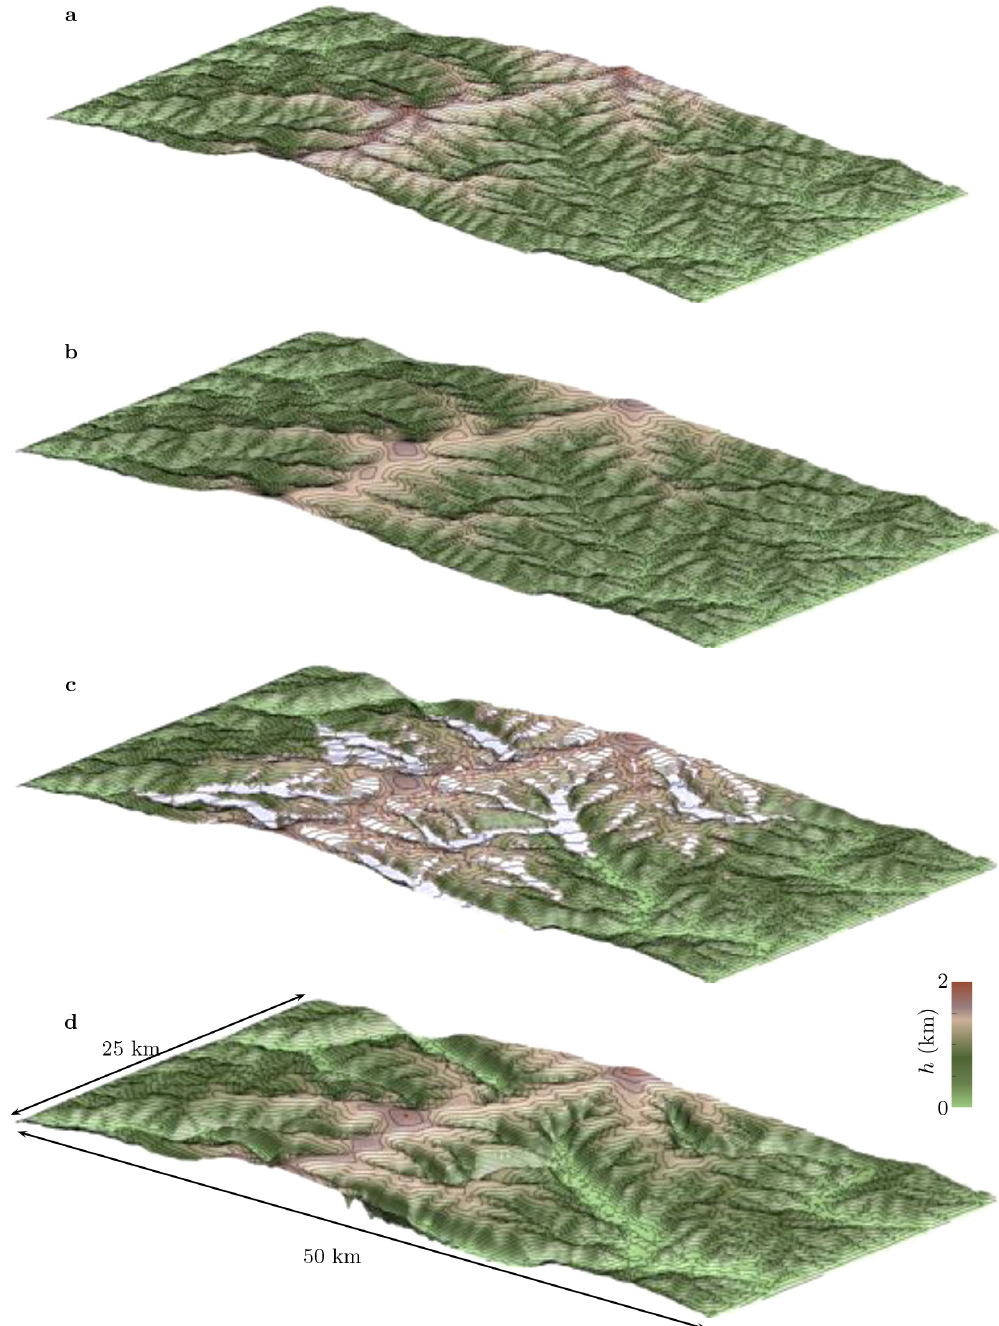
Figure 12. Computational experiment (no. 3) combining periglacial and subglacial erosion. The boundary conditions are the same as in Fig. 10, with the addition of glaciations over the last 3Myr of the total 14Myr simulation. Panel (a) : initial fluvial-style topography. Panel (b) : periglacial landscape after 11Myr, just before glaciations start. Panel (c) : a snapshot of a period with glaciers (after 13.2Myr). Note that the ice cover varies greatly with temperature and the final 3Myr are dominated by glacial cycles that repeatedly cover almost the entire landscape. During the interglacials the landscape is either free of ice or includes small valley glaciers high up. Panel (d) : final landscape after 14Myr. Glaciers have carved out deep troughs that are over-deepened to almost 500m below sea level. Smaller valleys have become hanging valleys. Summit flats are preserved owing to the presence of non-erosive, cold-based ice on the interfluves. The final topography is highly bimodal, with (1) a high plateau region comprised of many summit flats at similar elevation and (2) deep glacial valleys incised to or below sea